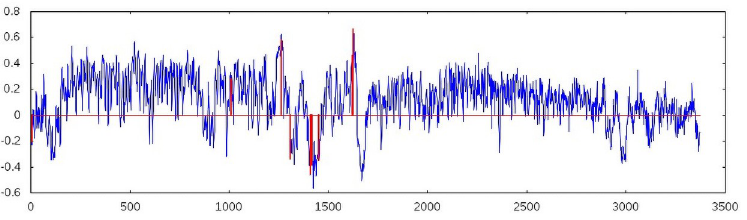
Fig 7. Pairwise correlation between spectral vector ~ S and marker vector ~ L for the marker with the highest f correlation, billirubin, is shown in blue. The x-axis shows the columns of the spectral matrix S, representing a frequency f . From the pairwise correlations, a linear combination is derived, leading to a improved correlation with the marker while avoiding overfitting. The selection of weights leading to the highest correlation are shown in red. The minimum weight was set to 0.2, and nine spectral vectors were allowed, leading to a final correlation of 0.91 and a z- value of 12,94. The two triplets of nearby spectral vectors may indicate that weight optimization (beyond pairwise values) could lead to a further increase in correlations. Exposure time: 104